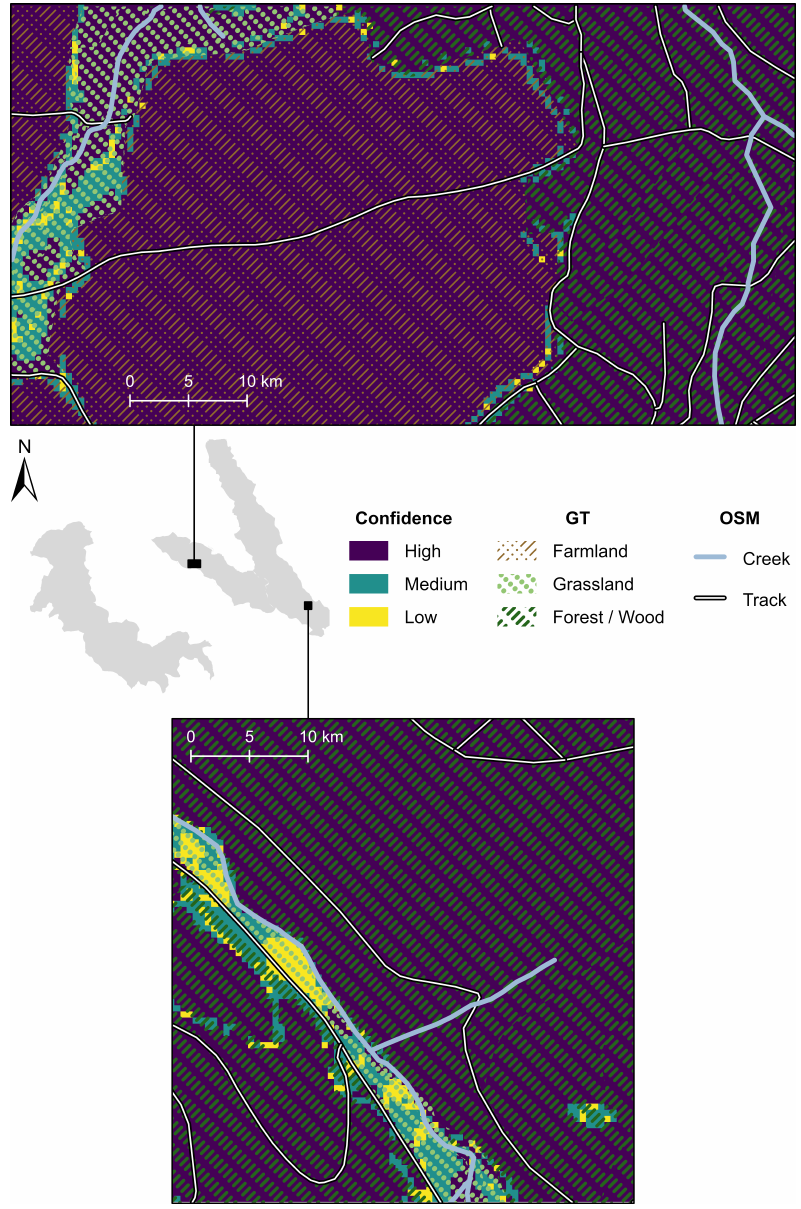
Figure 14. Detailed visualization of the confidence concerning the classification result of the LSTM F . The confidence is calculated as the voting of the individual predictions of the six sequences. A unison vote implies high confidence (dark blue), an absolute majority vote implies medium confidence (green), and no majority implies low confidence (yellow). We refer to the OpenStreetMap data as OSM and the Ground Truth data as